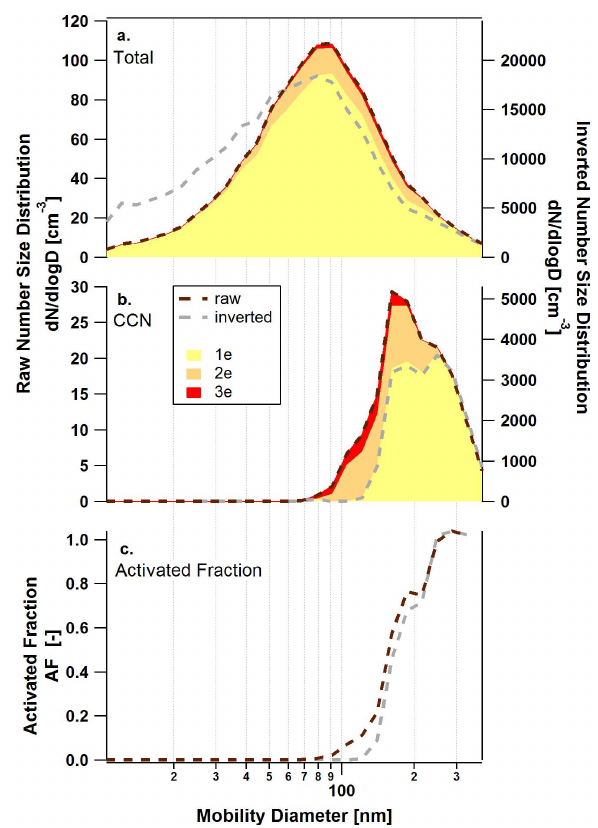
Fig. 2. Example of the particle and CCN (at SS = 0.1%) number size distribution measurements. Panel (a) shows measured raw par- ticle concentration ( c(D) , brown dashed line) and the corresponding calculated contributions from the singly (yellow shaded area), dou- bly (orange shaded area) and triply (red shaded area) charged parti- cles. The grey dashed line shows the inverted number size distribu- tion ( n(D) ). Panel (b) is same as panel (a) but for raw and inverted CCN number size distributions ( c CCN (D, SS ) and n CCN (D, SS ) , respectively). The difference between the contributions from the singly charged particles to the raw measurement and the inverted number size distribution originates from the diameter dependent DMA transfer probability and the charging probability. Panel (c) shows the calculated raw (brown dashed line) and inverted (grey dashed line) activated